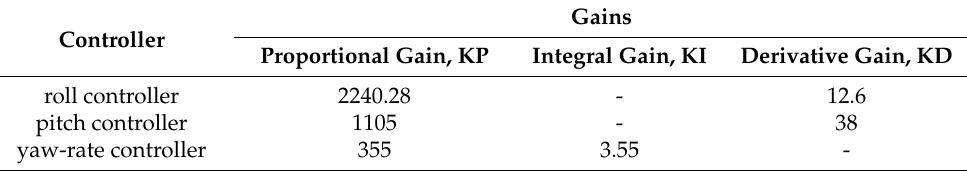
Table 4. Controller gains.